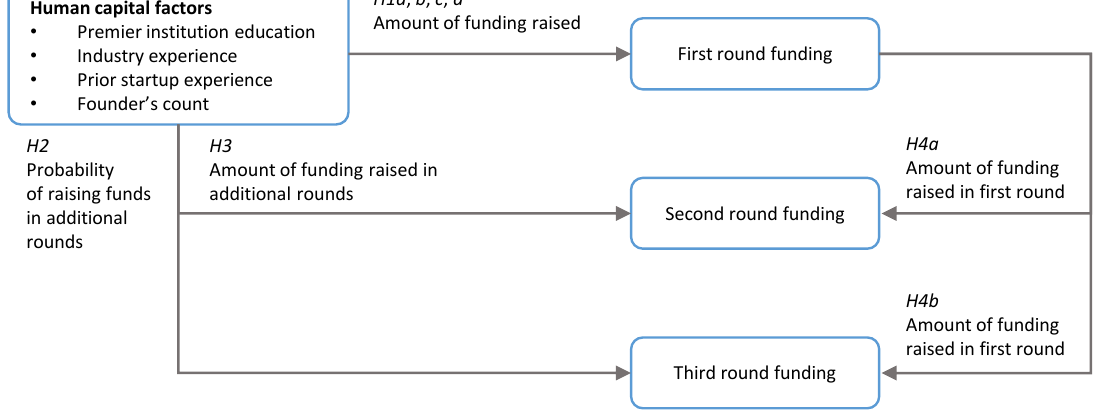
Figure 1. Signaling effects of human capital factors across multiple funding rounds and inter-funding round